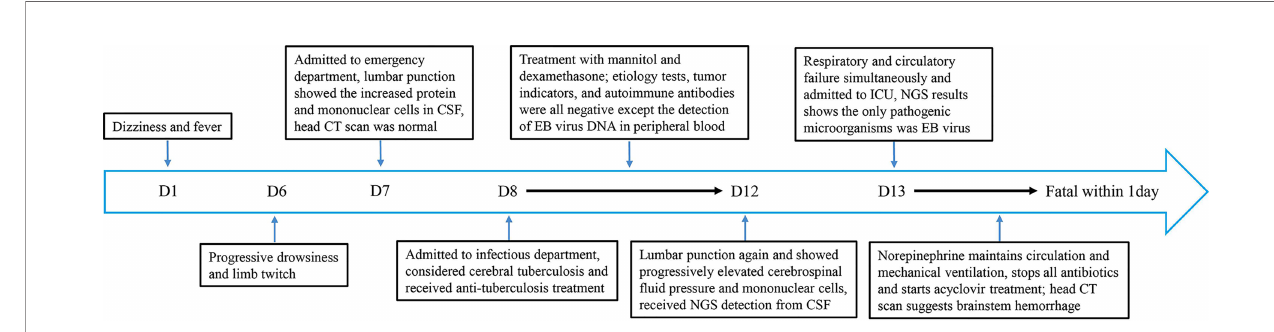
TABLE 1 | Summary of in fl ammatory markers and CSF examination during the whole hospitalization course.